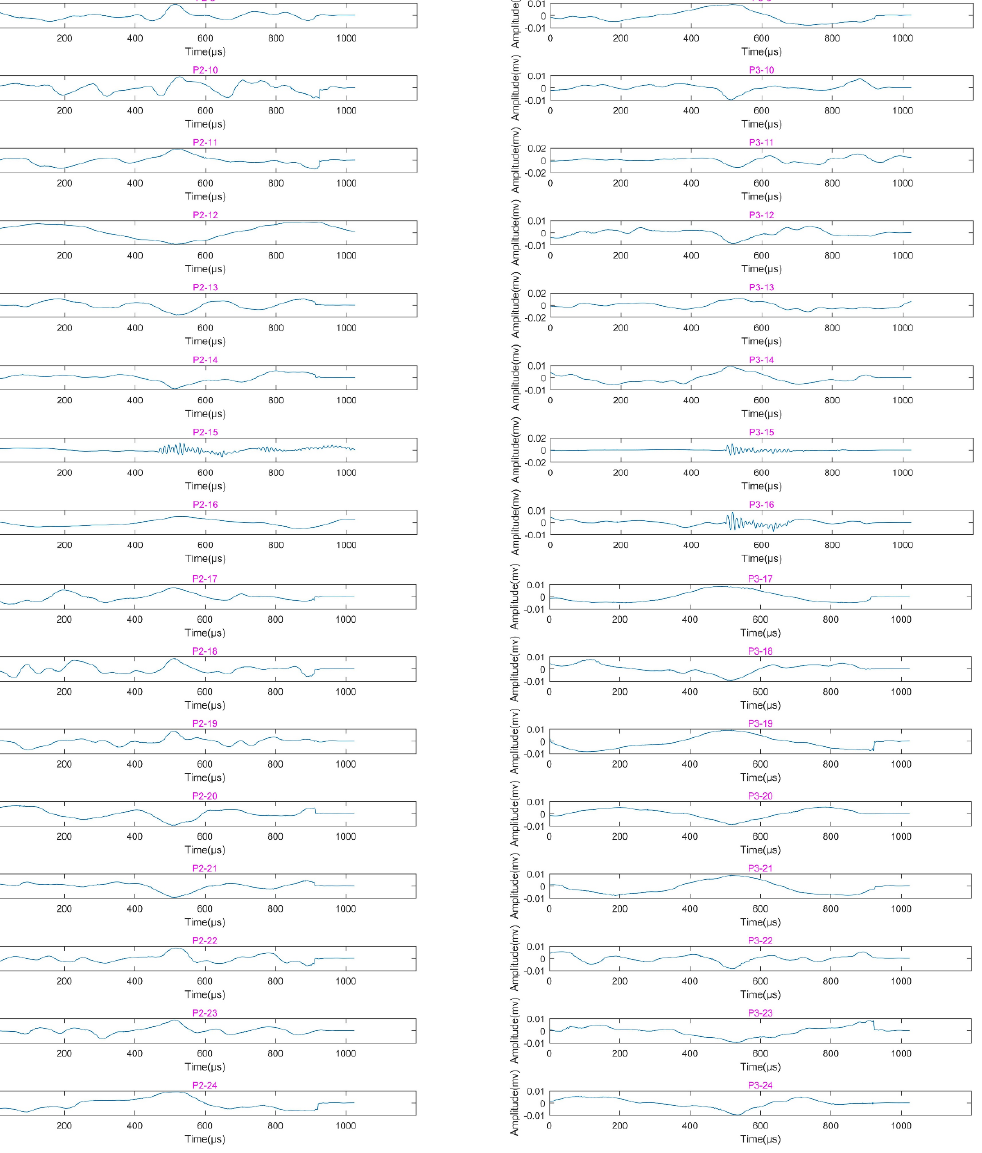
Figure 8. Reconstructed waveforms of AE signals with largest centroid frequency collected by sensors P2 and P3 in working cases 9–24 after wavelet decomposition and de-noising. The waveforms of sensors P2 and P3 in working case 15 (subpictures P2–15 and P3–15, respectively) contain high- frequency fluctuations, which indicates the initiation of ruptures in the tunnel arch vault.